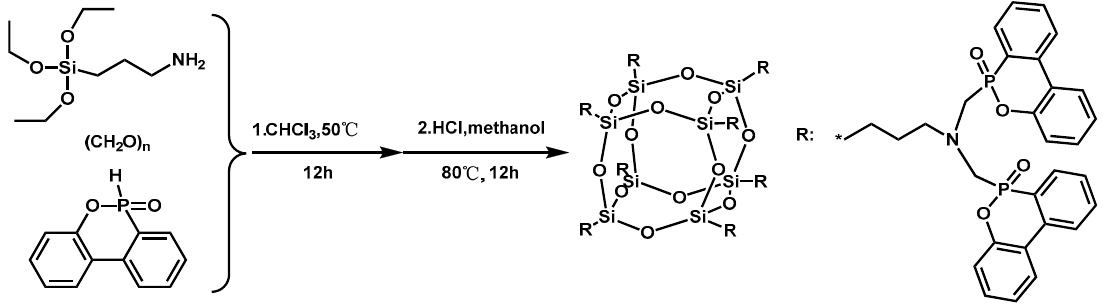
Figure 18. Synthetic route of ODMAS. Readapted with permission from Ref. [161], Copyright 2017, The Royal Society of Chemistry.